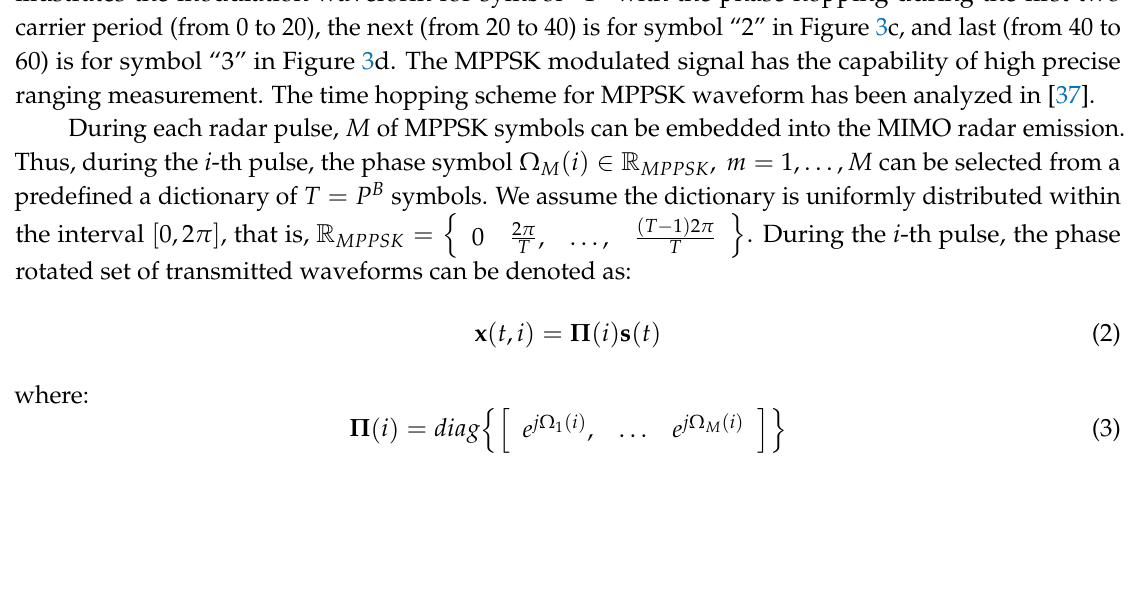
Figure 3. ( a ) 4-PPSK modulated waveform for symbol “0”; ( b ) 4-PPSK modulated waveform for symbol “1”; ( c ) 4-PPSK modulated waveform for symbol “2”; ( d ) 4-PPSK modulated waveform for symbol “3”.